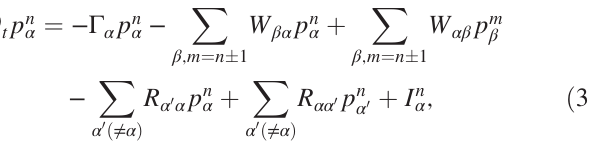
FIG. 1. Exciton propagation across a chain of dimerized units. (a) Linear chain of dimerized unit cells separated by a distance l consisting of interacting transition dipole moments, and a sketch of the geometry and level diagram of two neighboring unit cells. Energy transfer between subunits is considered to be incoherent. (b) Distance dependence of the couplings between unit-cell excitons. For large distances (far field, l=l 0 ≳ 3 . 2 ), the coupling between bright states V dominates (red line). At short distances, bb dark states are mainly involved in the energy transfer, which proceeds through the couplings V and V (blue and purple dd bd lines). Because of these couplings, the stationary populations ¯ p b and ¯ p deviate from those in the thermal equilibrium regime d that characterizes the far-field limit (gray dotted line). ¯ Γ (c) Effective decay rate (left) and diffusion length l (right) diff as a function of the local exciton-phonon coupling, quantified by ffiffiffiffiffiffiffiffiffiffiffiffiffiffiffi p R ¼ R R . The interdimer distance is fixed to l=l 0 ¼ 1 . 78 , bd db corresponding to the yellow line in (a). For low fluorescence yield and antiparallel dipoles (blue line), the coupling to local phonons is beneficial for long-range energy transfer as a consequence of a reduced decay rate. A larger fluorescence yield (red line) or a change in exciton symmetry (green line) leads to an unfavorable scaling with respect to R : Coupling to local phonons hinders long-range energy transfer. The model parameters take